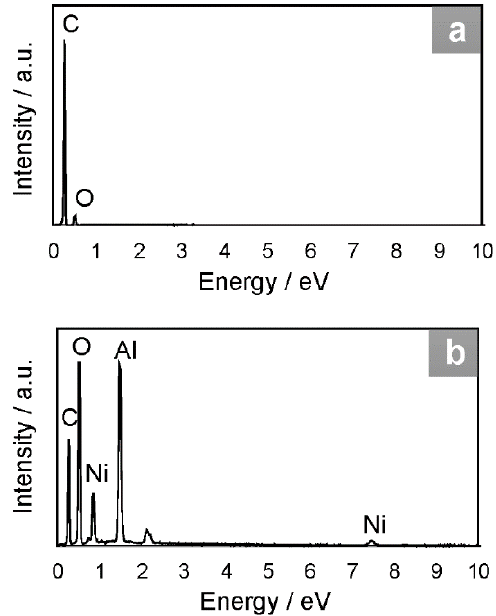
Figure 6. EDX spectra of ( a ) GQDs and ( b ) NiAl 2 O 4 /GQDs.